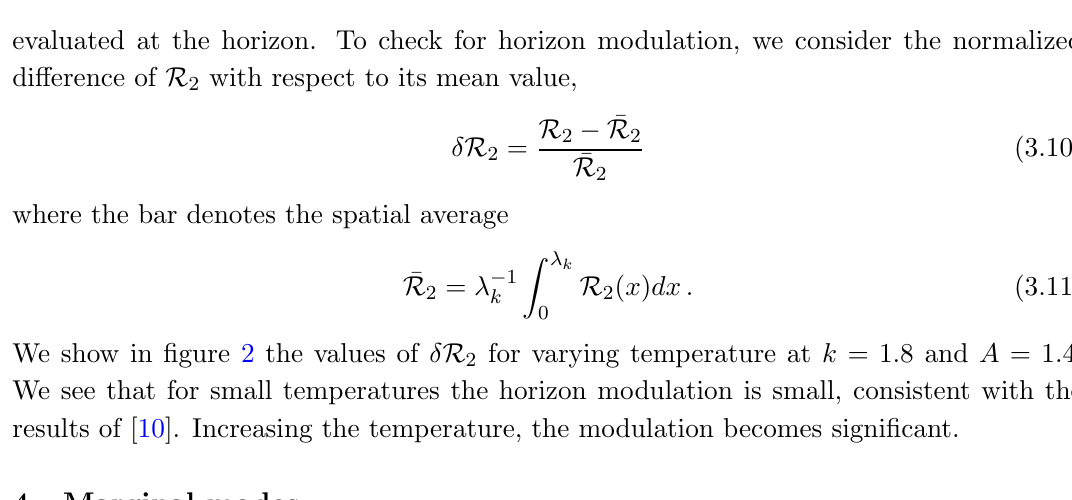
Figure 2 . Pro(cid:12)les of the relative modulation of curvature on the horizon for the ionic lattice backgrounds at di(cid:11)erent